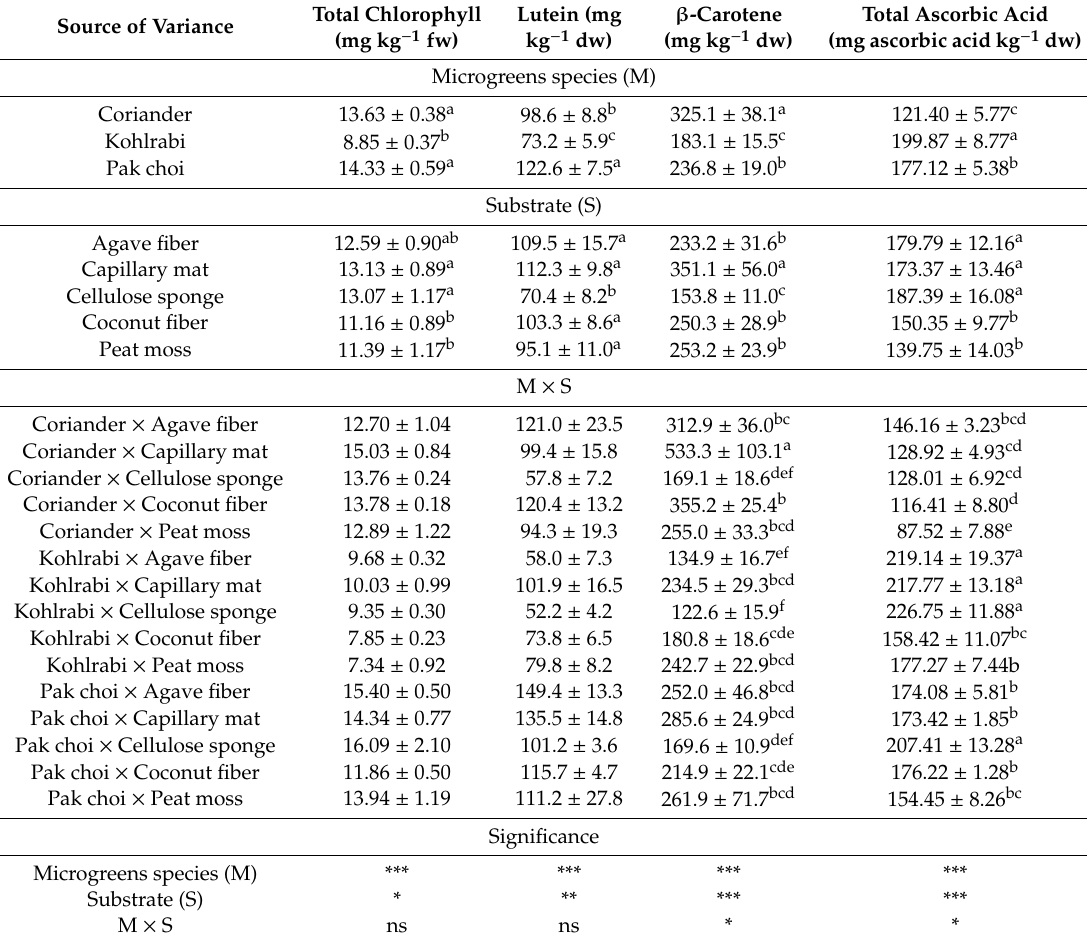
Table 4. Chlorophyll, lutein, β -carotene and ascorbate content of coriander, kohlrabi and pak choi substrates grown on natural fiber and synthetic substrates under a controlled environment. All data are expressed as mean ± standard error, n =